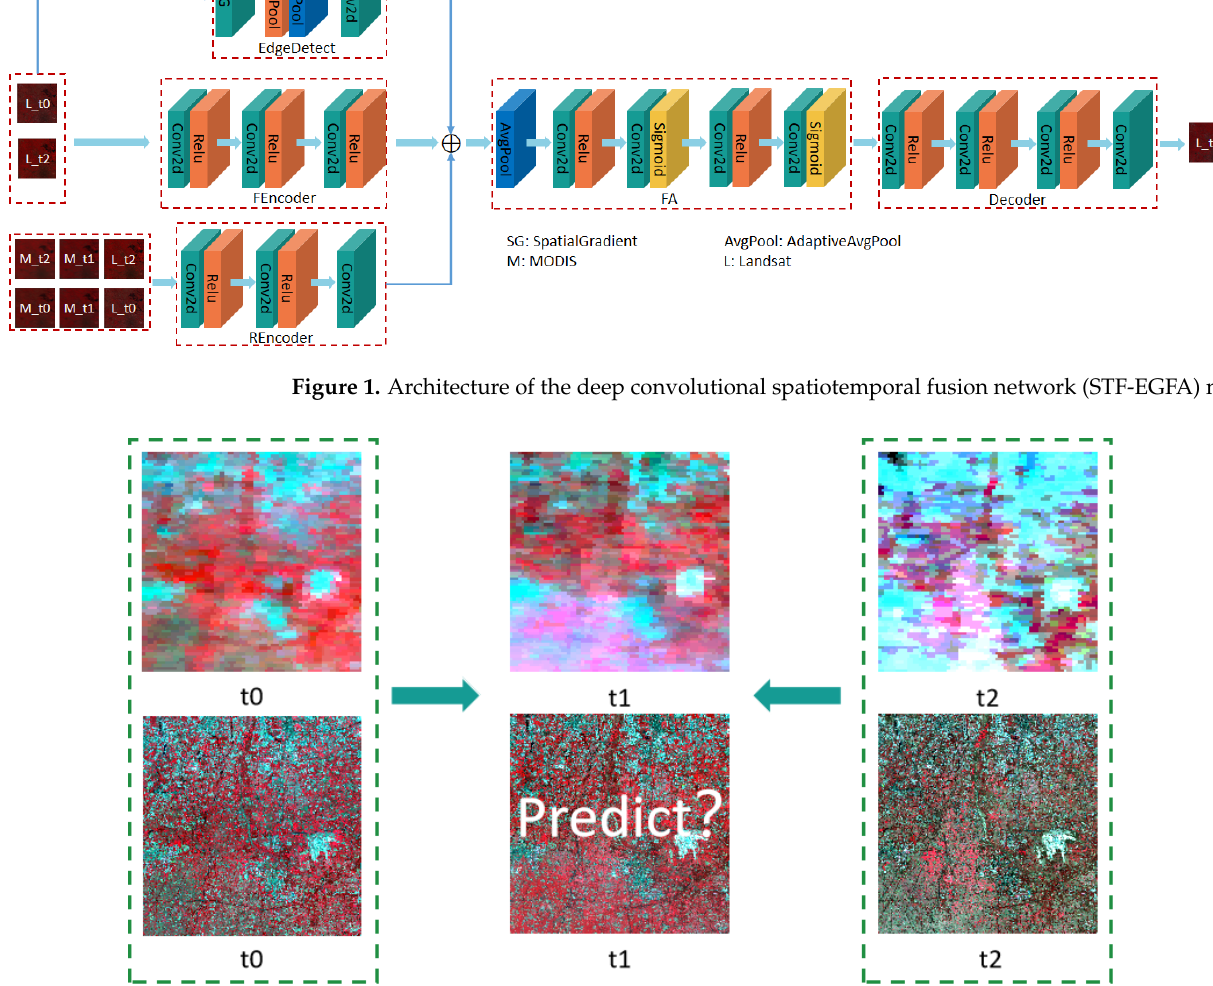
Figure 1. Architecture of the deep convolutional spatiotemporal fusion network (STF-EGFA) model.